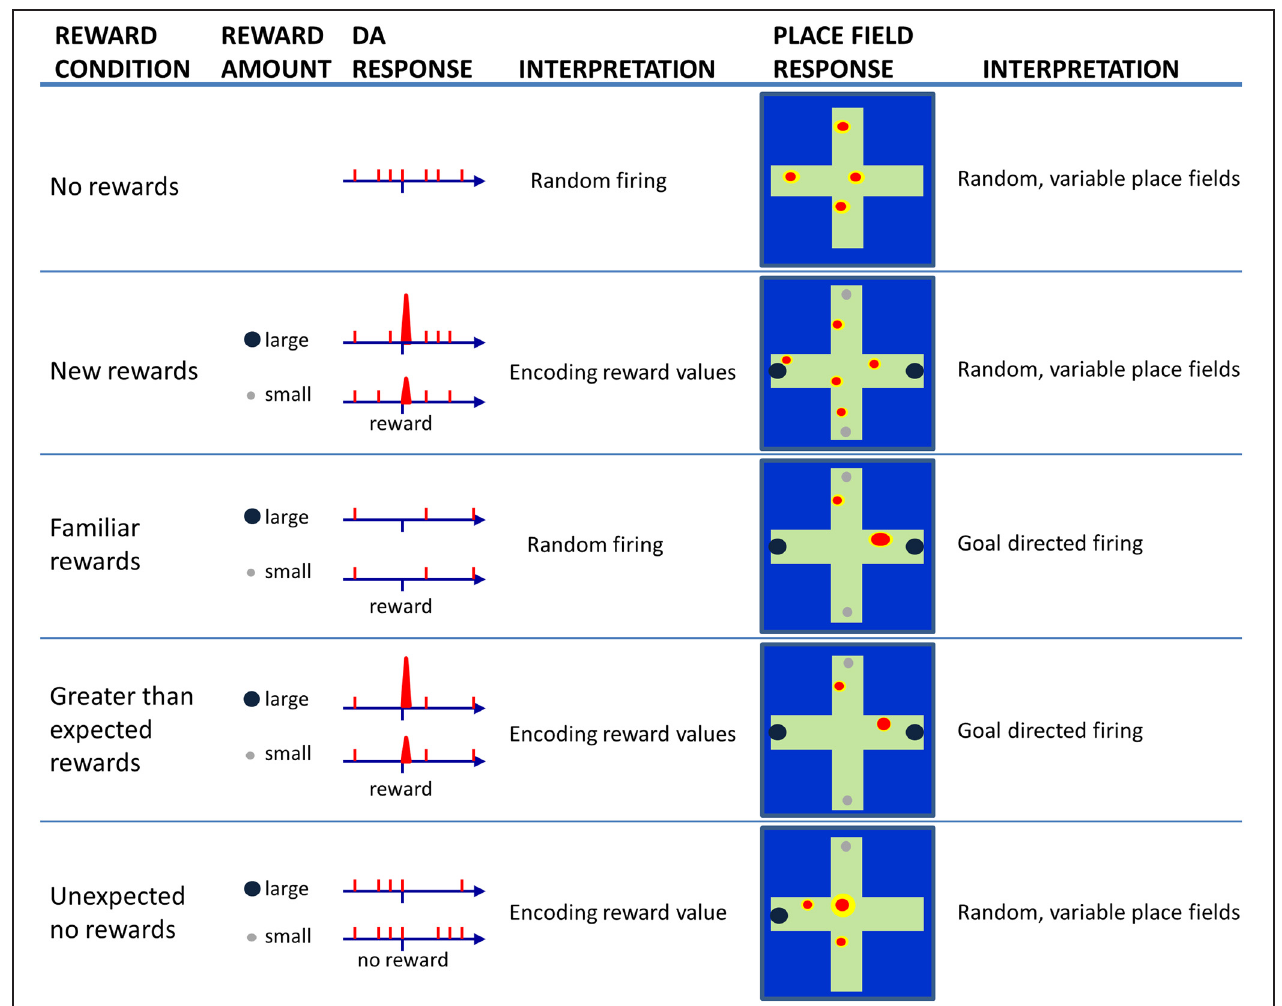
FIGURE 2 | Schematic illustration of dopamine (DA) cell responses to encounters of large or small rewards as a rat solves a maze task under different reward conditions (left). Consistent with the literature, DA cells appear to fire randomly at low rates as animals traverse a maze when no rewards are present (No reward). When a rat encounters reward for the first time (New rewards), DA cells exhibit phasic burst firing to a larger extent following encounters with large rewards than small rewards. In this case, DA cells are considered to be encoding reward values. When the reward-finding task is learned (Familiar rewards), DA cells should no longer fire upon reward encounters. If the rat then unexpectedly encounters reward, one will again observe burst firing by DA cells in proportion to the magnitude of reward (Greater than expected rewards). If a trained rats goes to a location that was previously associated with rewards, but the reward is unexpectedly absent (Unexpected no rewards), then DA cells are observed to show brief